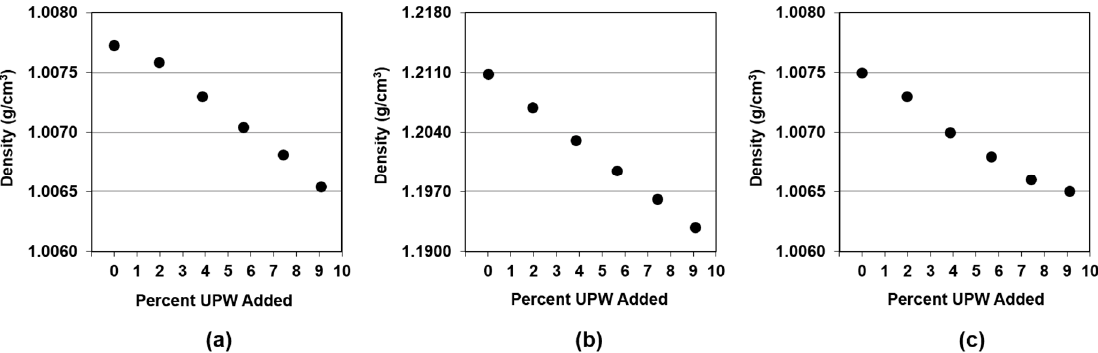
Figure 2. Slurry density as a function of amount of UPW added for ( a ) Fujimi PL-7106; ( b ) Klebosol 1501-50; and ( c ) CMC W7801.